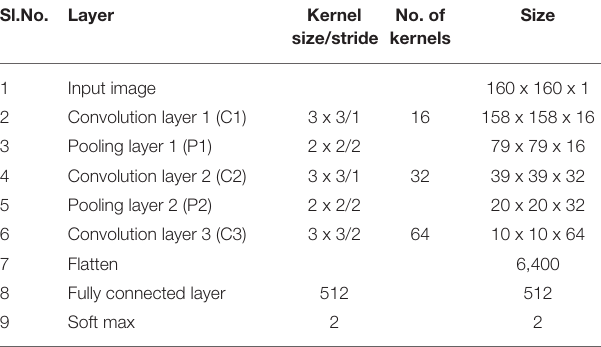
TABLE 2 | CNN parameters